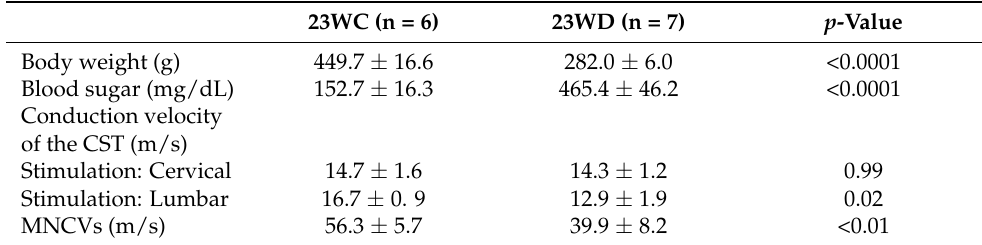
Table 1. Body weights, blood glucose levels, and conduction velocities of CST fibers in animals used for electrophysiological experiments.